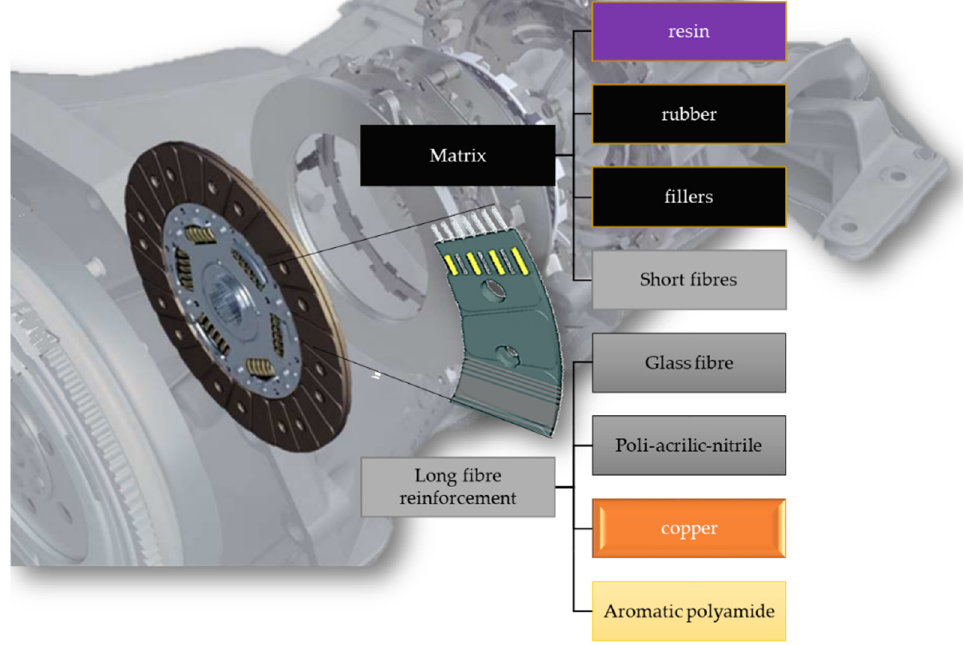
Figure 1. Structure and components of the hybrid composite friction facing.